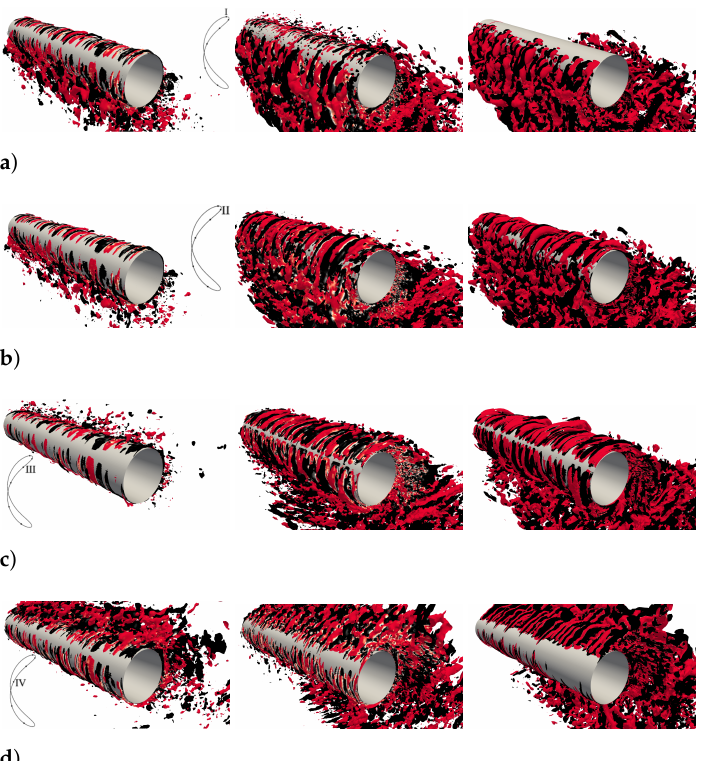
Figure 17. Stream-wise vorticity iso-contours of the reconstructed flow showing the Taylor–Görtler structures. From left to right: 2, 10, and all modes. Results presented at different instants of the cross-flow oscillation cycle are shown in the figure. Each image is represented every 1/8 of the cycle starting from the maximum elongation in y . ( a ) t = 0, ( b ) t = 1/8 τ , ( c ) t = 1/4 τ , ( d ) t = 3/8 τ